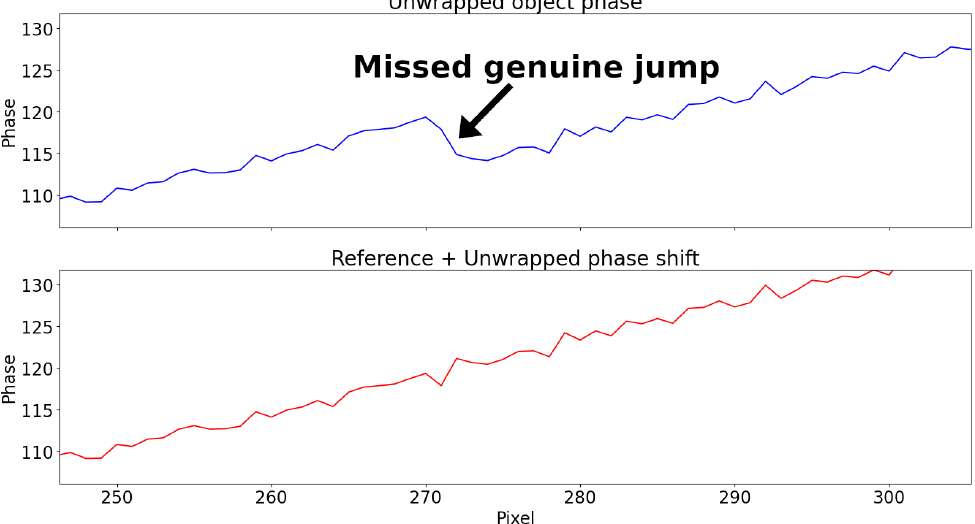
Figure 11. Unwrapping of the simulated dent signal with added white noise ( σ = 0.6) using Itoh’s algorithm. Detail of one of the several genuine 2 π -jumps missed using Equation (11) ( top ) but not using Equation (13) ( bottom